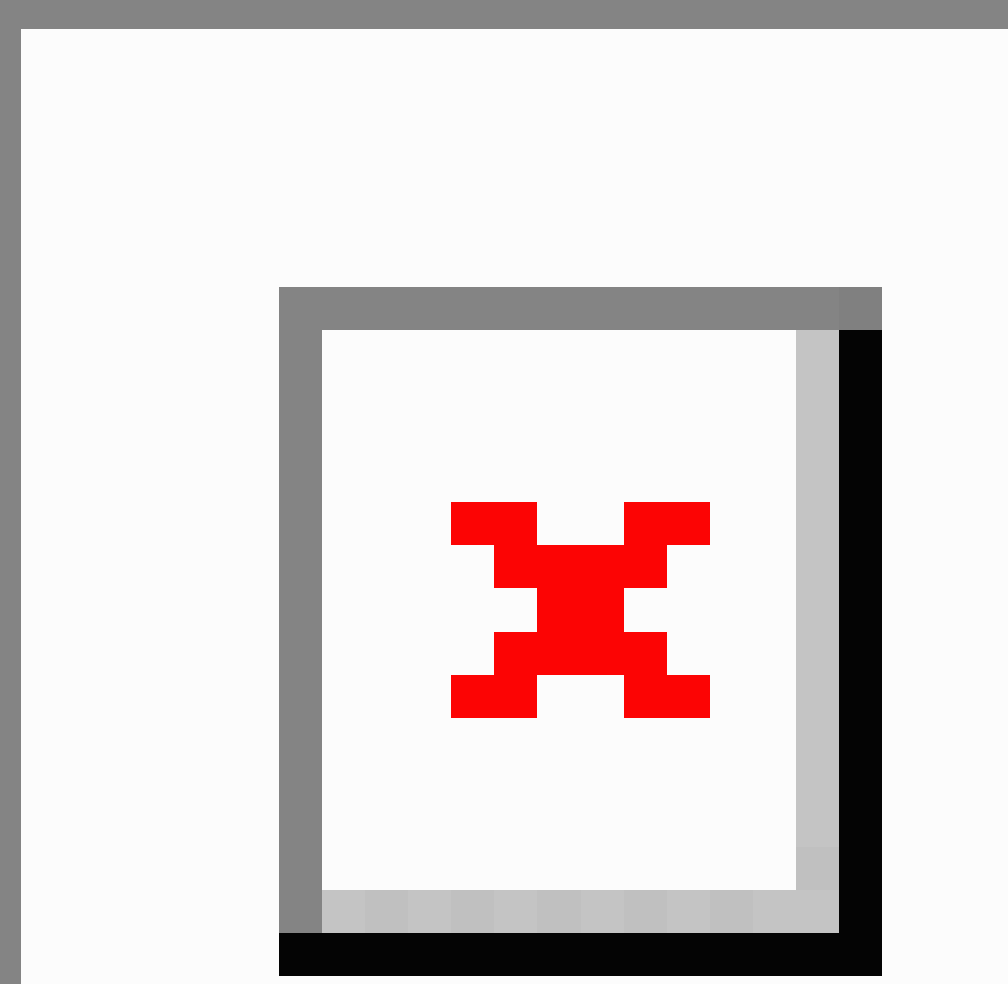
Figure 7. Comparison of the rates of glaucoma patients’understanding of their target intraocular pressure (* P <.001, Fisher exact